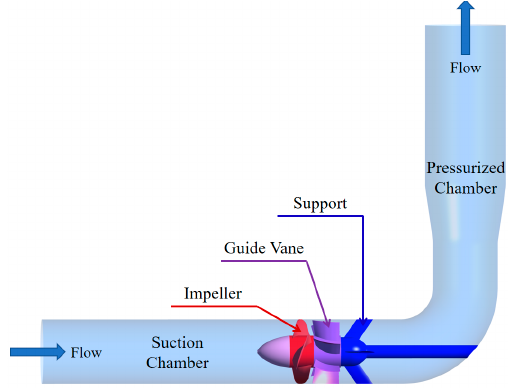
Figure 2. Axial flow pump model.